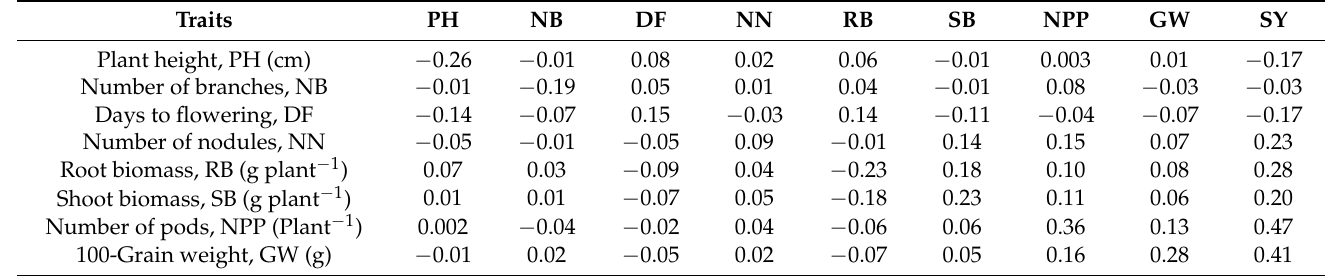
Table 12. Path analysis of direct and indirect effects of soybean characters on seed yield (SY).